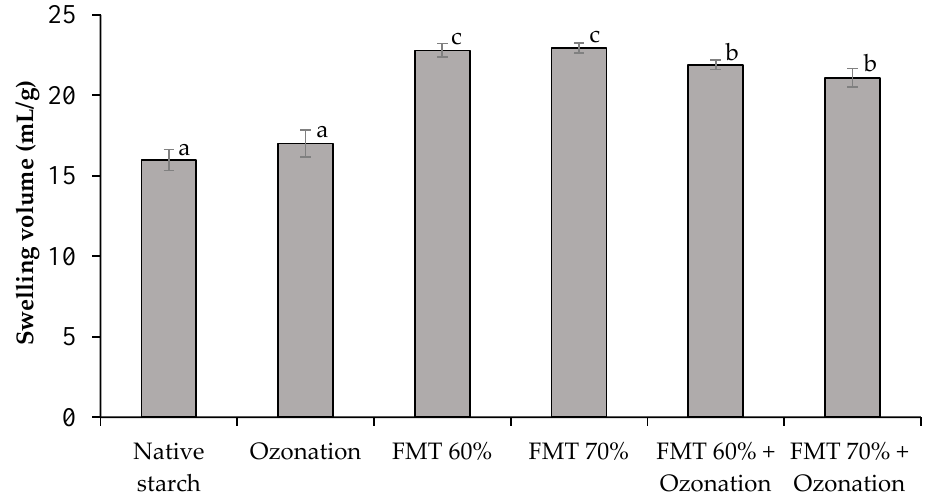
Figure 1. The swelling volume of native adlay starch and adlay starch modified by FMT and ozonation. Different letters show significant differences between treatments ( p < 0.05).